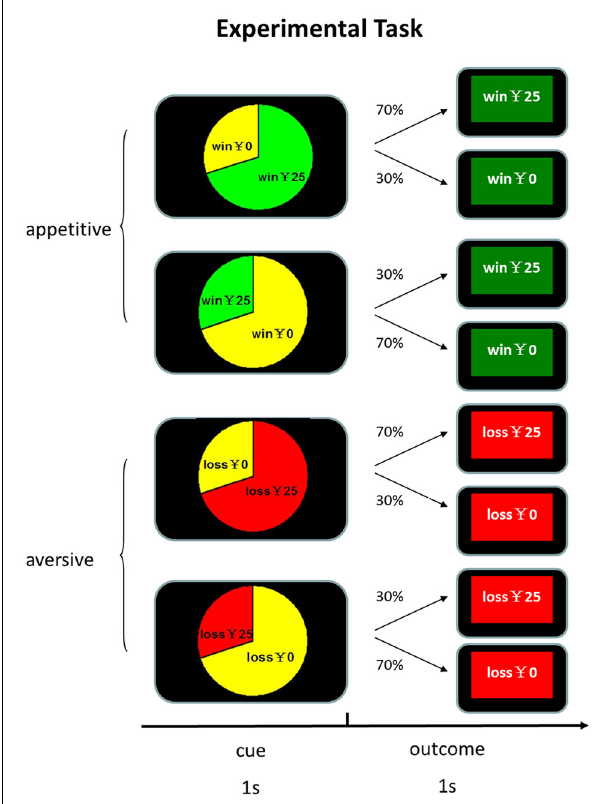
FIGURE 1 | Experimental task design. Participants were presented with a pie chart which explicitly indicated the true frequencies of outcomes for 1s. Then the feedback of outcome was shown for 1s, followed by a 500ms